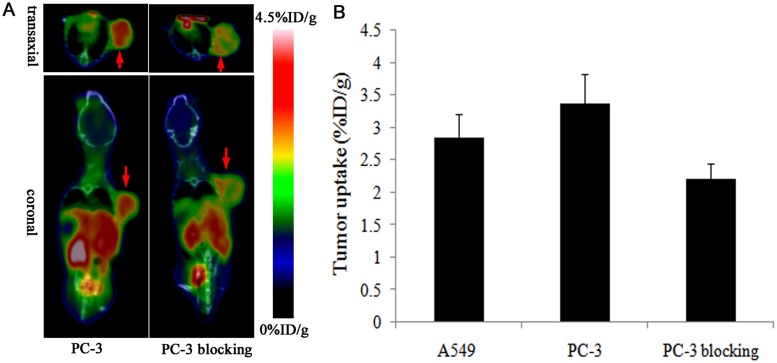
Tumor uptake of 18F-FP-PEG2-β-Glu-RGD2 was inhibited by co-injection of an excess dose of RGD.(A) MicroPET-CT images of PC-3 prostate tumor-bearing mice without/with a blocking dose of RGD (4 mg/kg body weight) at 60 min after injection of 18F-FP-PEG2-β-Glu-RGD2. (The red arrows indicated PC-3 prostate tumor). (B) The tumor uptake of 18F-FP-PEG2-β-Glu-RGD2 in PC-3 prostate tumor and PC-3 prostate tumor treated with cold RGD blocking at 60 min after injection (mean ±SD, n = 4 per group).